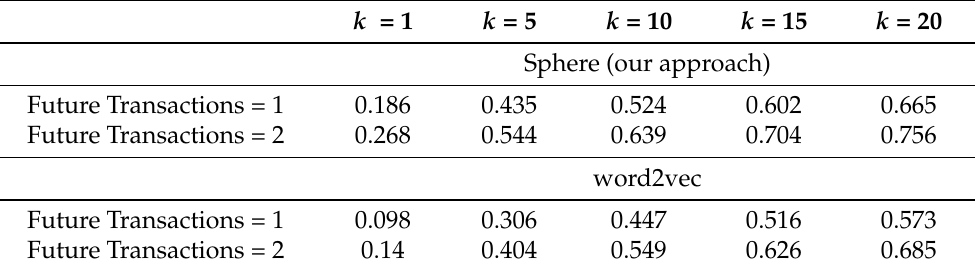
Table 3. The Hit Rate of the Recommendation Results for the Proposed Sphere Model and